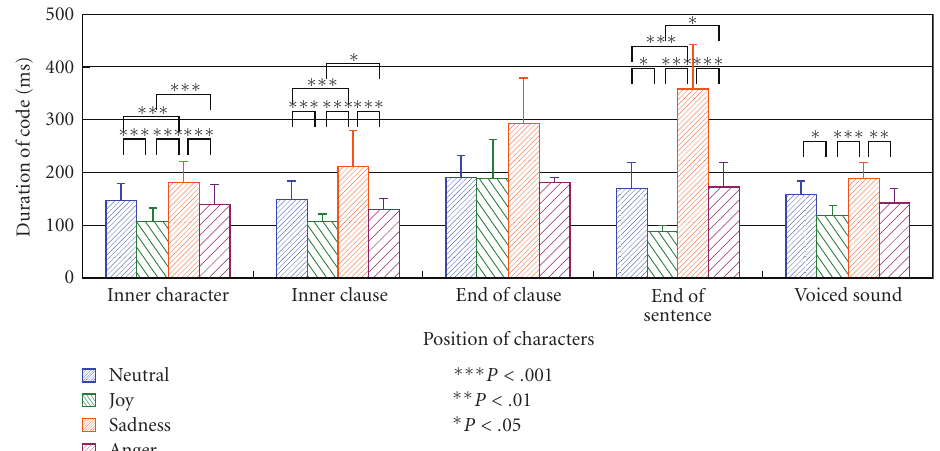
Figure 16: Mean of duration of code as a function of emotions and position of characters for one-handed Finger Braille (error bars represent standard deviations).